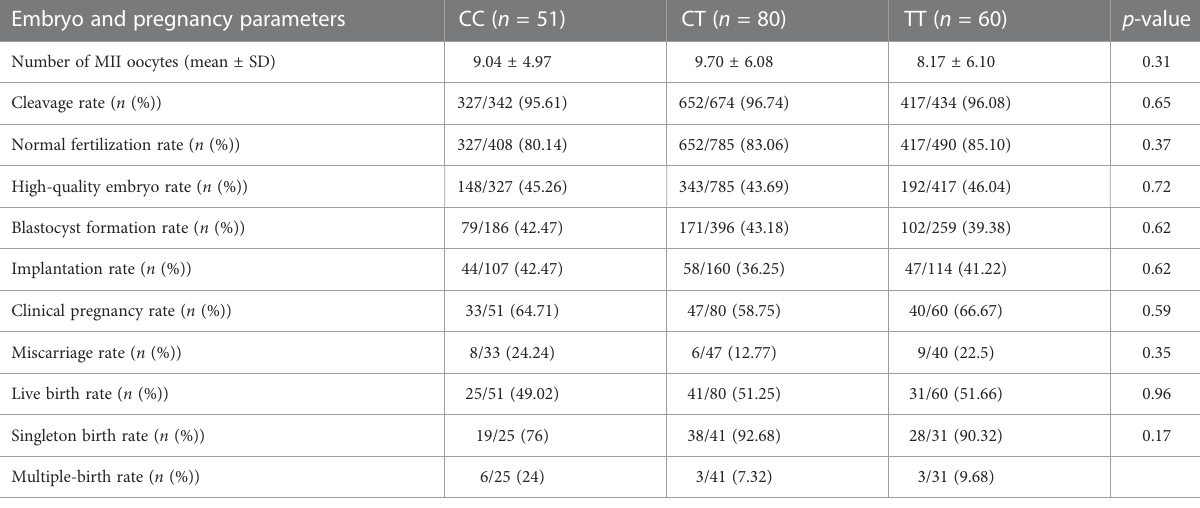
TABLE 4 Embryo quality and pregnancy outcome in association with MTHFR polymorphism. Embryo and pregnancy